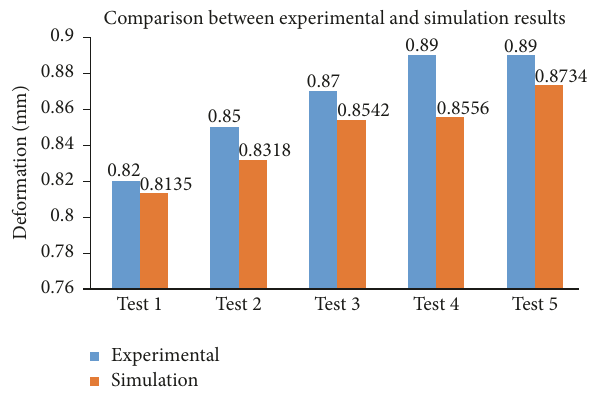
Figure 23: Comparison of experimental and simulation deforma- tions.